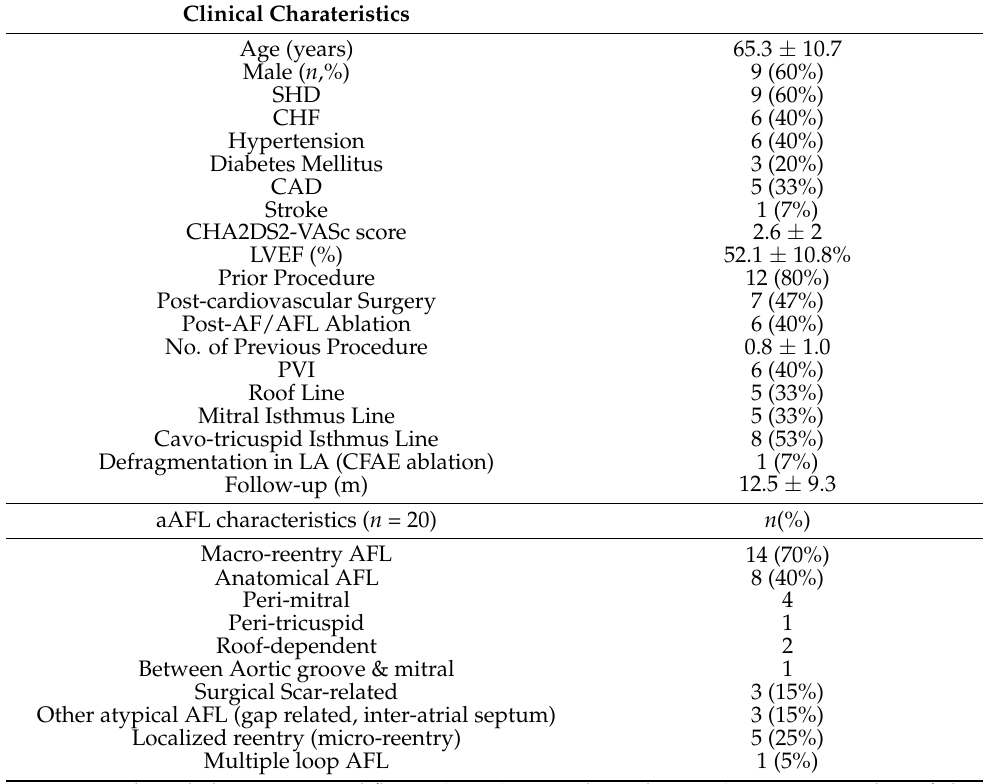
Table 1. Patients’ Clinical Characteristics ( N = 15) and Atypical Atrial Flutter Characteristics. Clinical